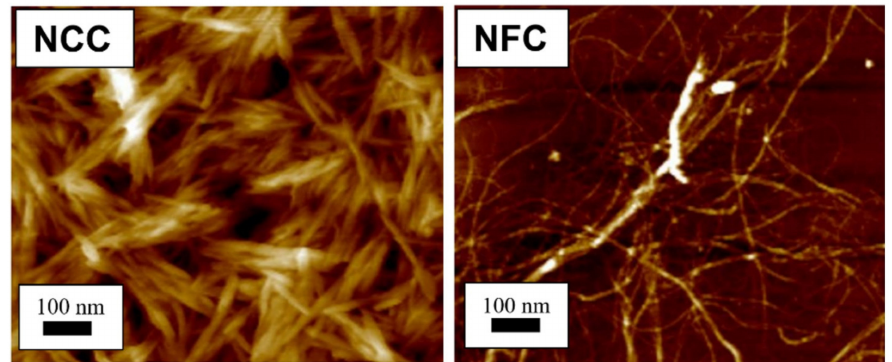
Figure 1. Atomic force microscopy images show different structure between nanocrystalline cellulose (NCC) [23] and nanofibrillated cellulose (NFC) [24]. (Reproduced with copyright permission from Ilyas et al.